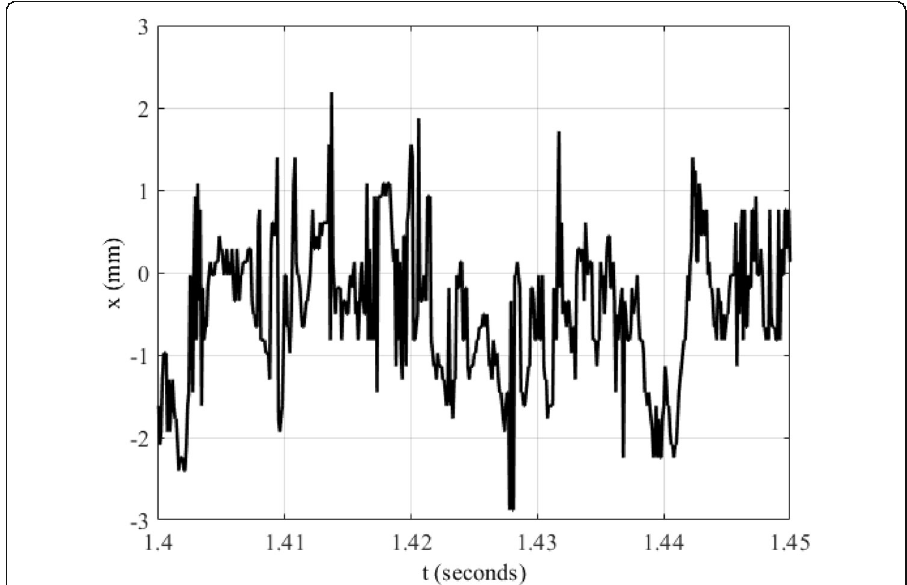
Fig. 11 A subset of the data from Fig. 10 showing the normal shock wave position (with respect to the time-averaged shock wave position) from 1.40 to 1.45 s, as a function of time for vertical pixel number 277 for data acquired on 05 April